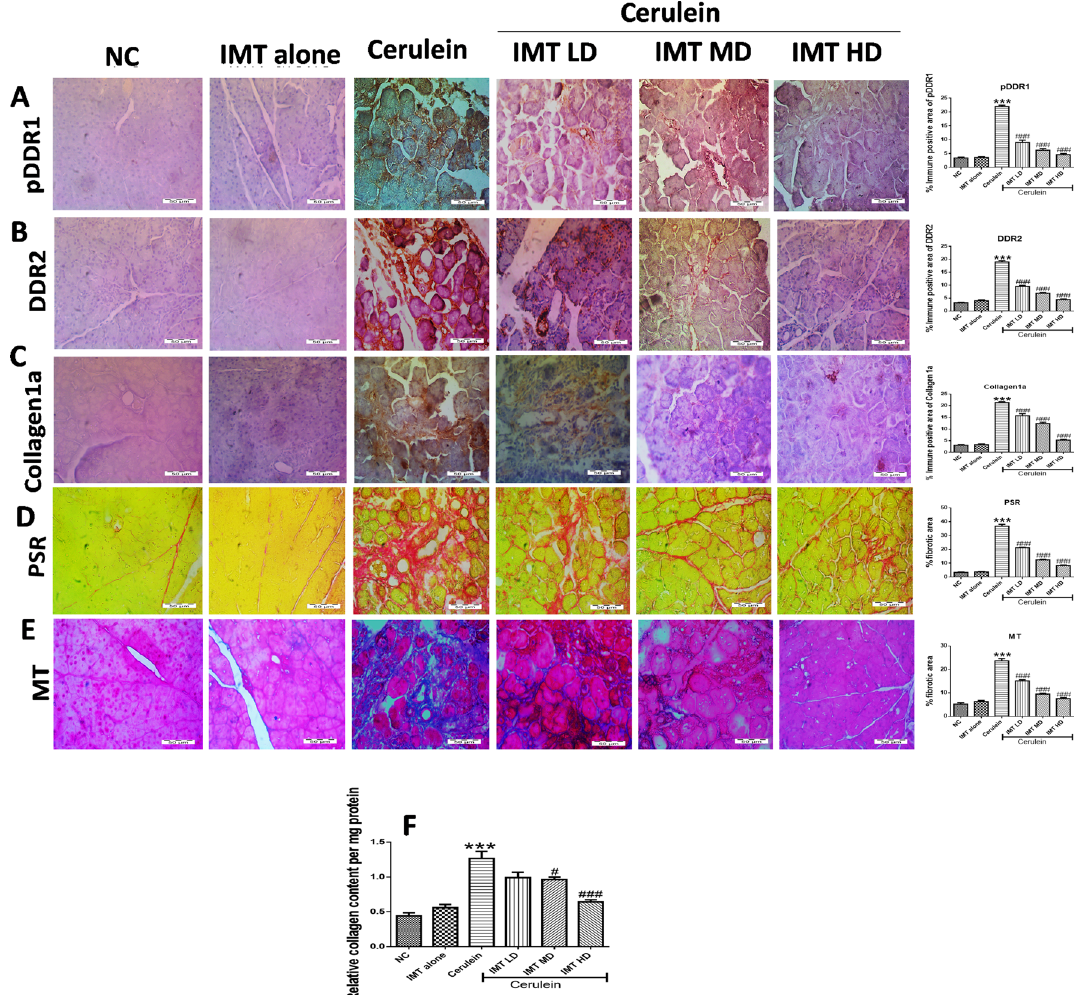
Figure 4. IMT controls collagen deposition in the pancreas ( A–C ) Representative photographs and quantitative analysis of immunohistochemistry of phosphorylated DDR1, DDR2 and collagen1a protein, ( D,E ) Representative photographs and quantitative analysis of PSR and MT staining in the pancreatic tissue, ( F ) Relative collagen content in pancreas estimated by Sircol assay. All values are represented as mean ± SEM (n = 10). Statistical significance was established using one-way ANOVA followed by Tukey’s multiple comparisons test where ***P < 0.001 vs Normal control, # P < 0.05, ### P < 0.001 vs